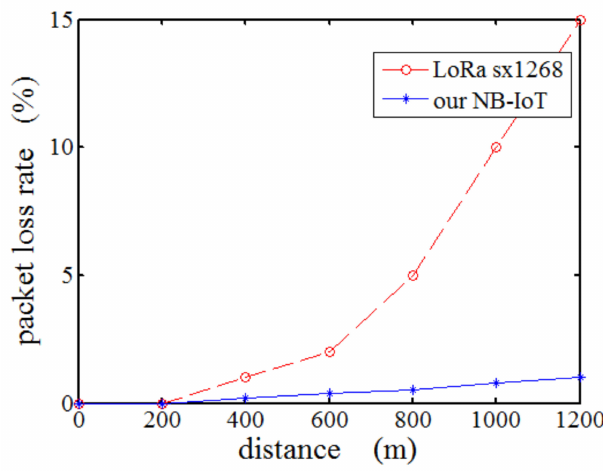
Figure 14. The packet loss rate of our NB-IoT module and LoRa